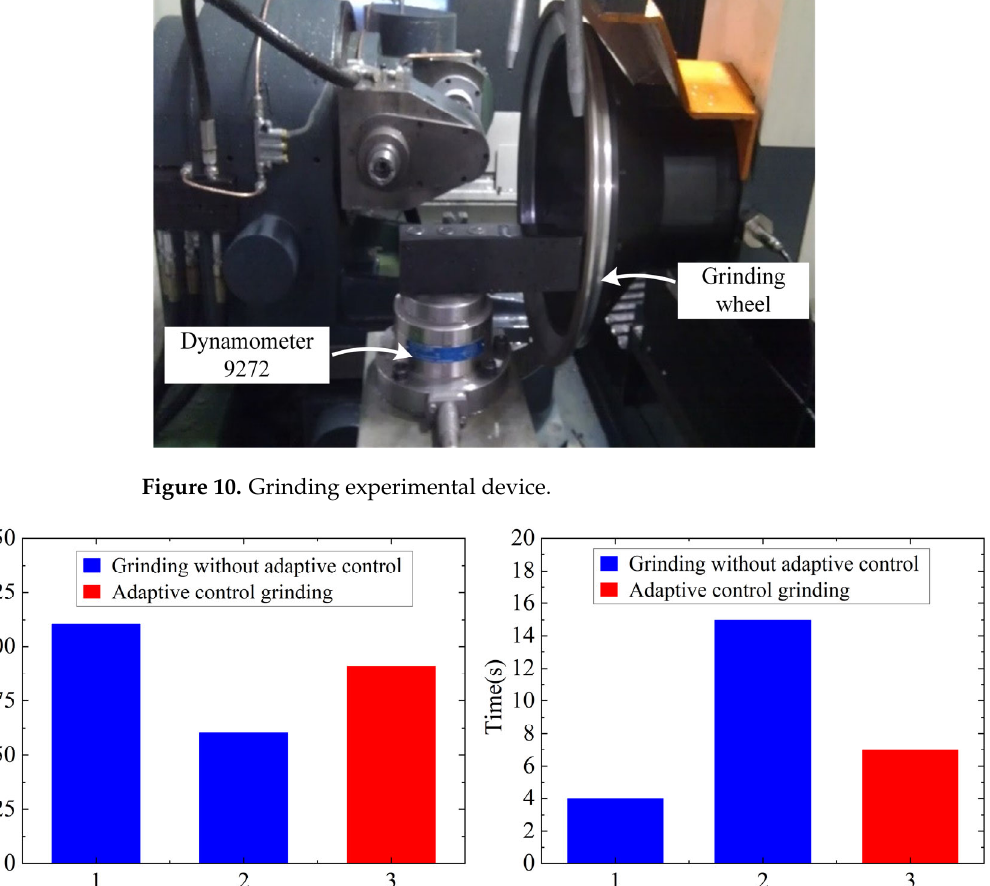
Figure 10. Grinding experimental device.